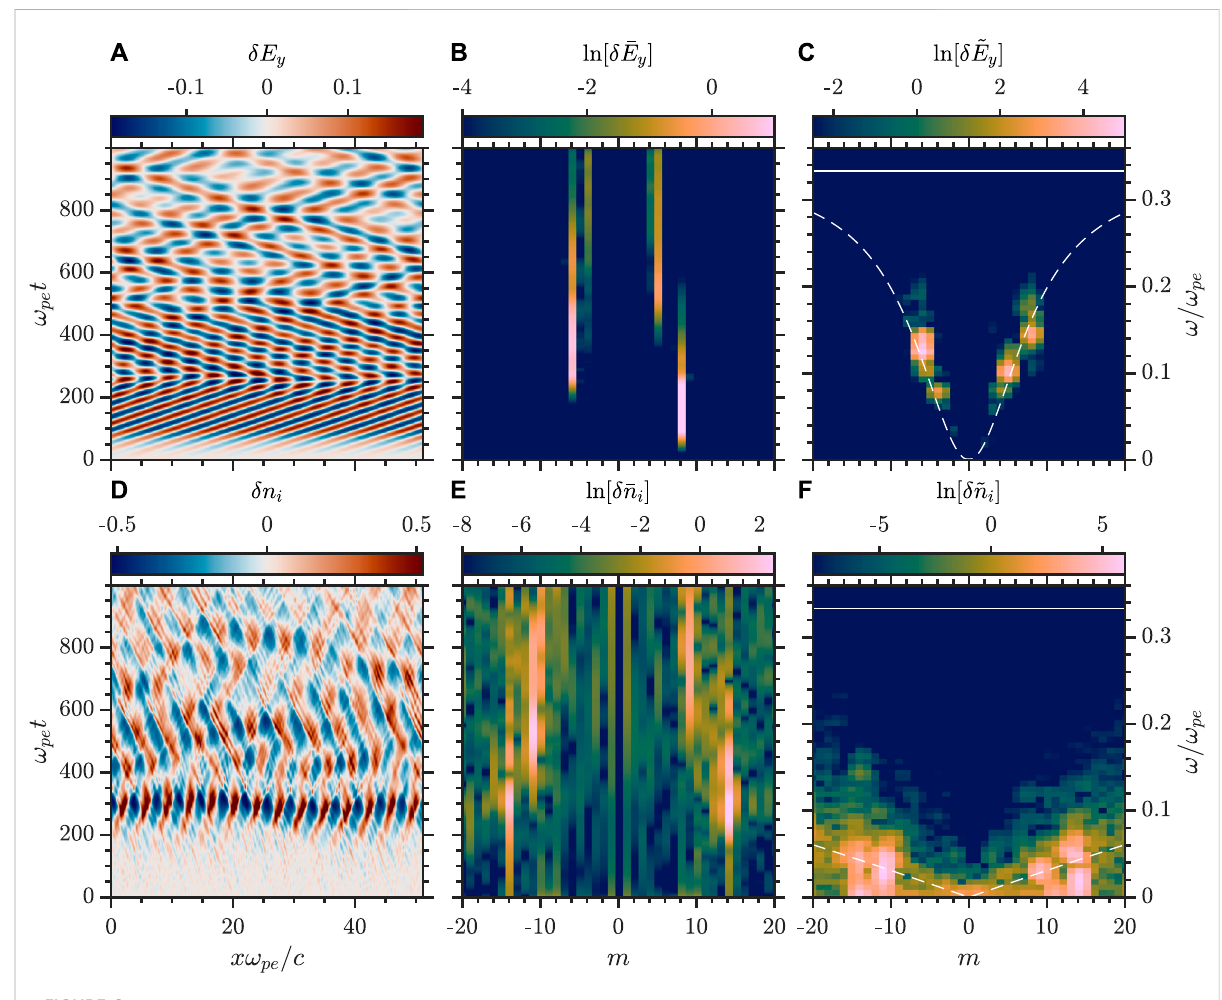
Triple parametric decay of whistler wave with δ B w / B 0 =0.103 (A) , (B) , and (C) xt -space, mt -space, and m ω -space of δ E y , respectively (D) , (E) , and (F) xt -space, mt -space, and m ω -space of δ n i , respectively. Dashed lines indicate the whistler and IAW branches in (C) and (F) , respectively, and the solid line is ω ce / ω pe